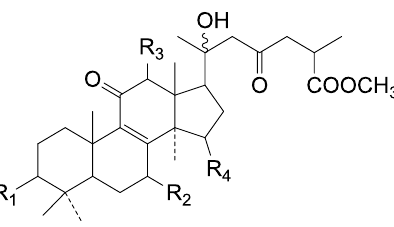
Figure 11. Structures of compounds 127 – 130